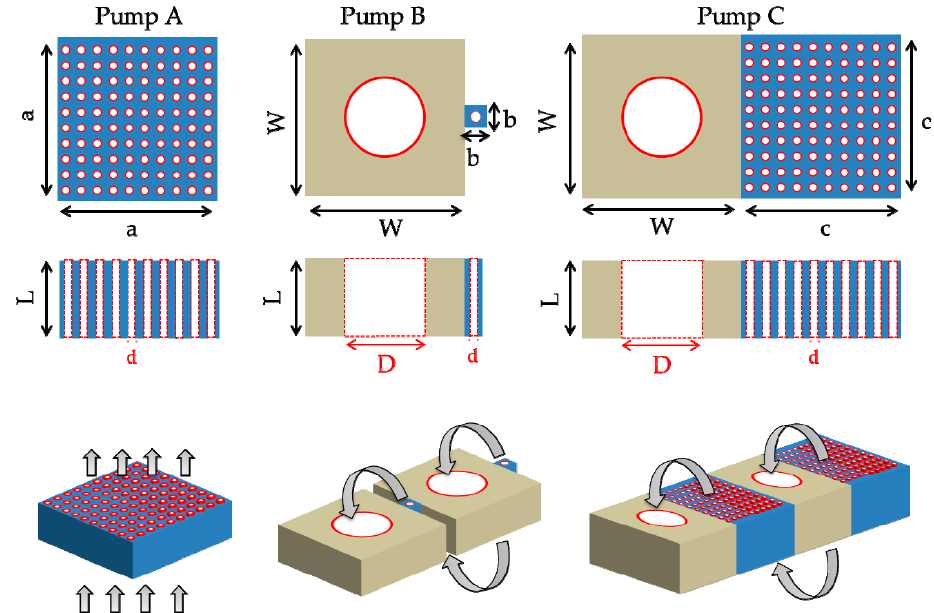
Figure 1. Representative view of single-stage pump A, and of two consecutives stages of multistage pumps B and C. Gray arrows denote the pumping flow direction, the hot and cold regions being at the top and the bottom of each stage, respectively.